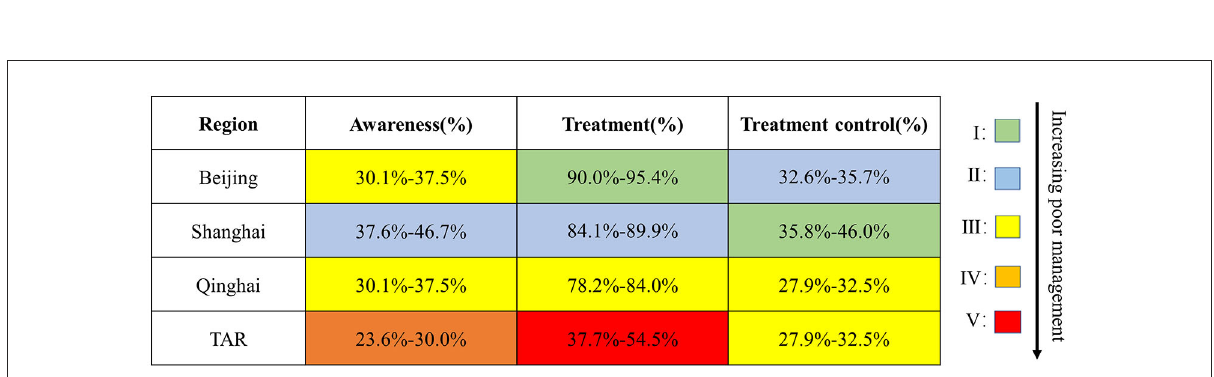
FIGURE6 Awareness: V: 18.0%–23.5%; IV: 23.6%–30.0%; III: 30.1%–37.5%; II: 37.6%–46.7%; I: 46.8%–56.1%. Treatment: V: 37.7%–54.5%; IV: 54.6%–78.1%; III: 78.2%–84.0%; II: 84.1%–89.9%; I: 90.0%-95.4%. Treatment control: V: 15.1%-19.6%; IV: 19.7%-27.8%; III: 27.9%-32.5%; II: 32.6%–35.7%; I: 35.8%–46.0%. TAR, Tibet Autonomous Region. Data were from the Report on Chronic Disease Risk Factor Surveillance in China